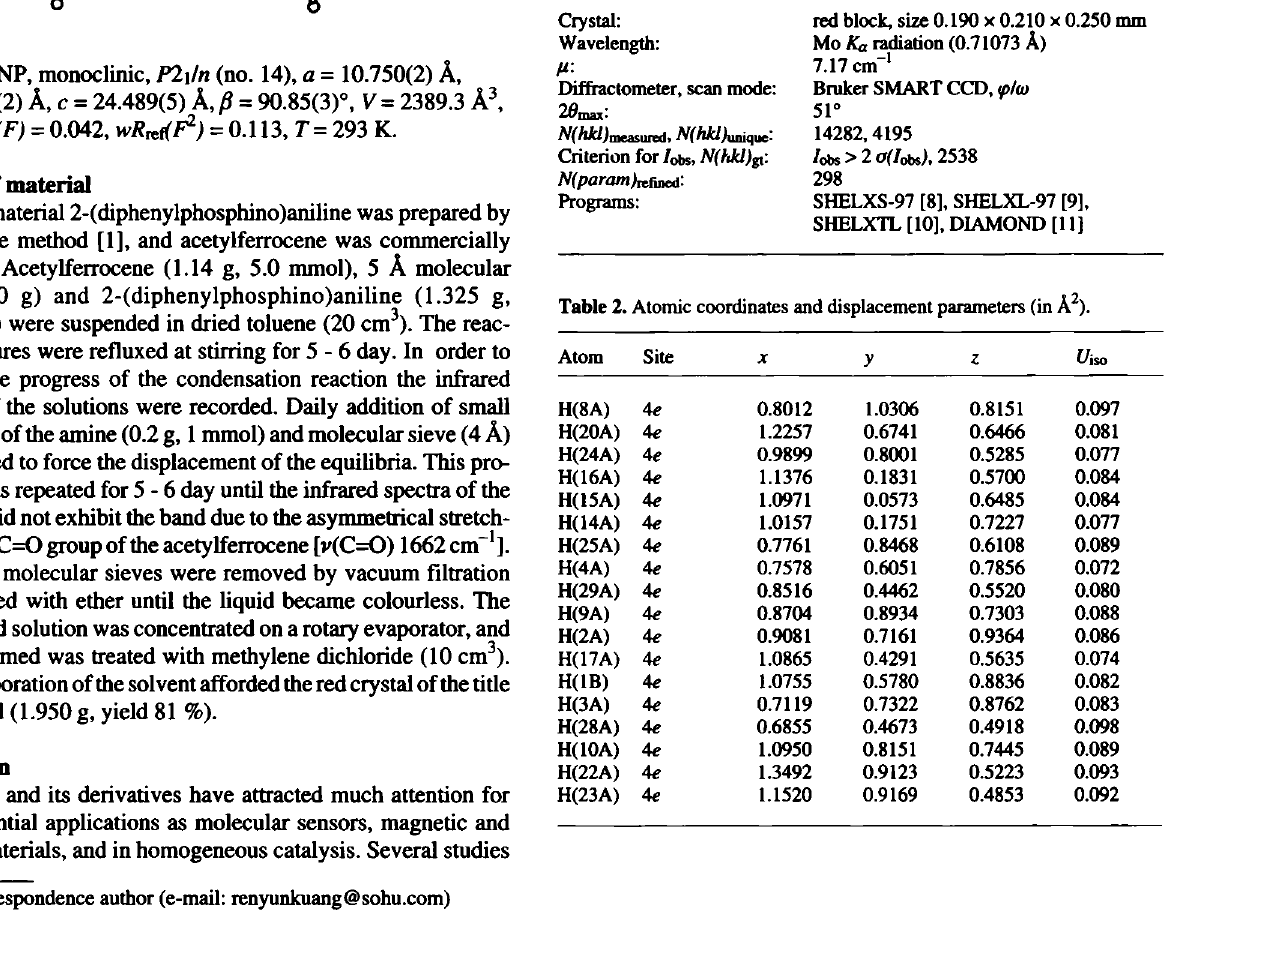
Table 1. Data collection and handling.